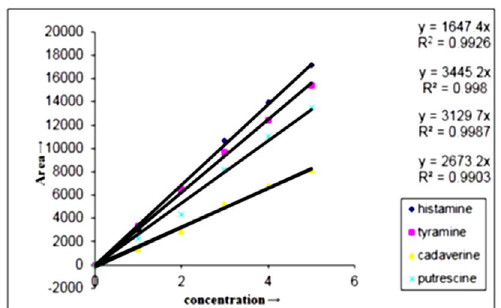
Fig. 5. HPLC Chromatogram of standard BAs Peak retention time at 18.1: Tyramine, 25.6: Putrescine, 26.6: Cadaverine, 28.4: Histamine